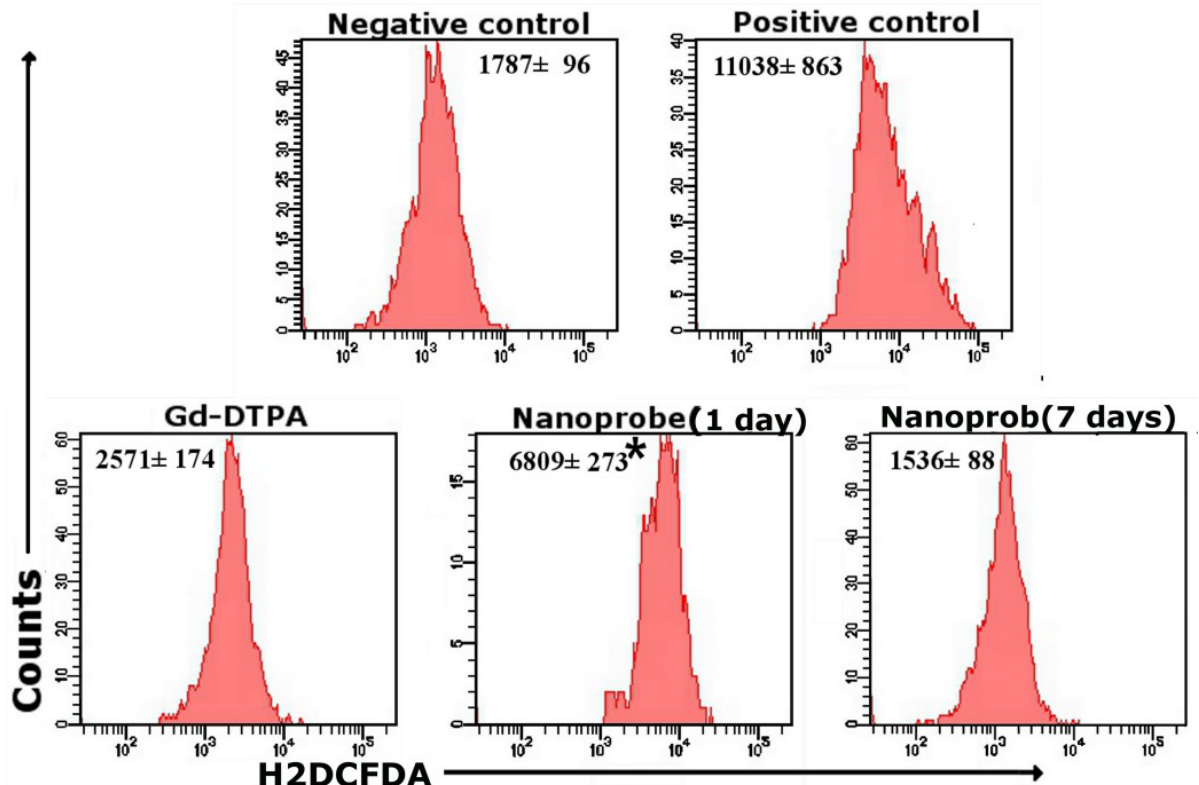
Figure 3. The generation of ROS in peripheral blood neutrophils was measured by flow cytometry 1 and 7 days after injection in Balb/c mice (20 μmol/kg, mean ± SD, n = 5). * p < 0.05 compared with the Gd-DTPA